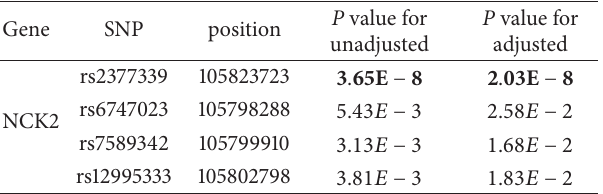
Table 5: Association of most significant SNPs in NCK2 with codependence of six individual substances dependence outcomes ( P